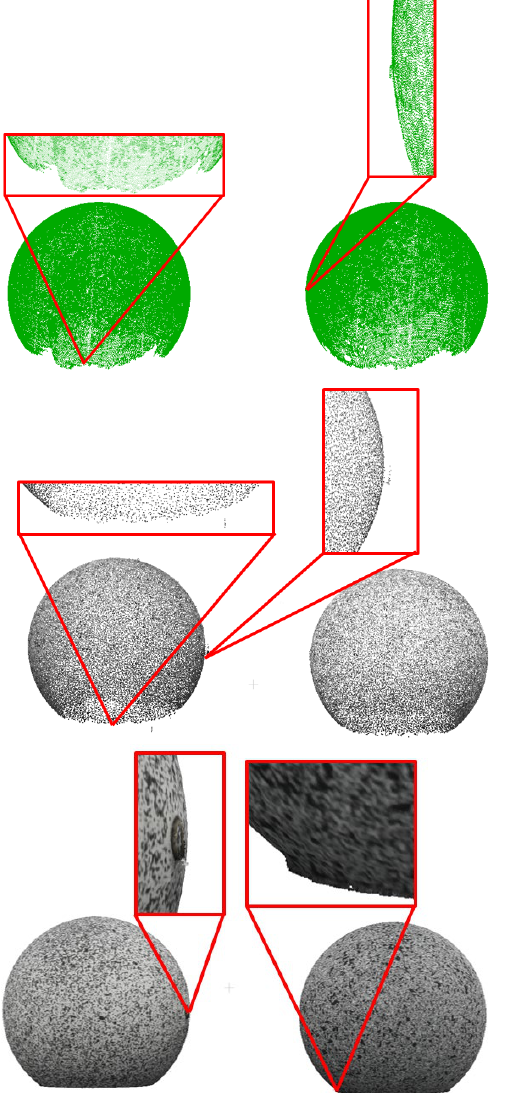
Figure 5. Point cloud of the reconstructed dumbbell bar with SmartScan (top), SURE (middle) and Metashape (bottom)